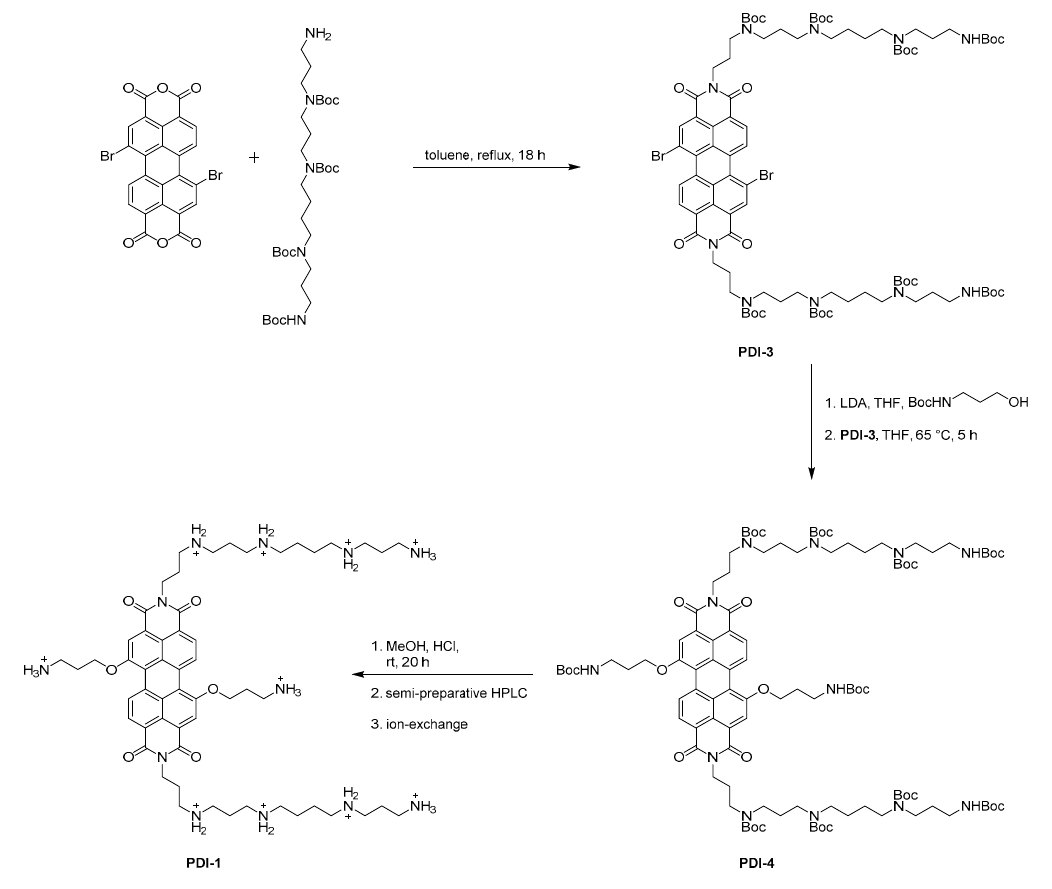
Scheme 4. Synthesis of probe PDI-1 , chloride counterions not shown.